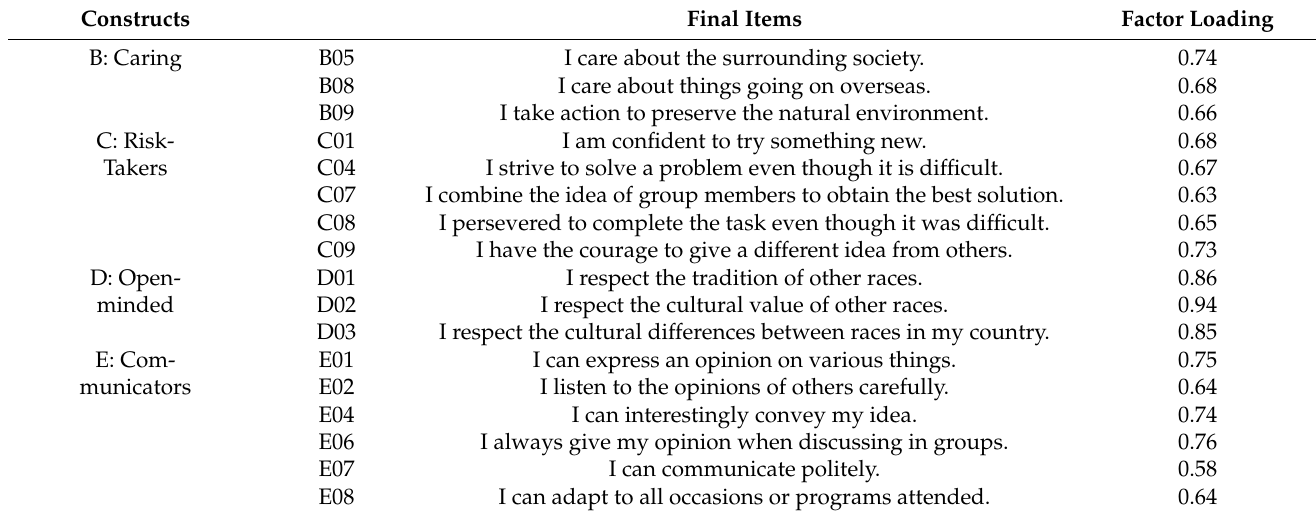
Table 8. 10IBLP-I final